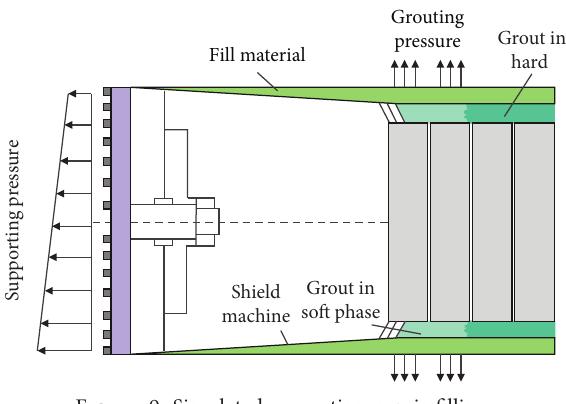
Figure 9: Simulated excavation gap is filling.